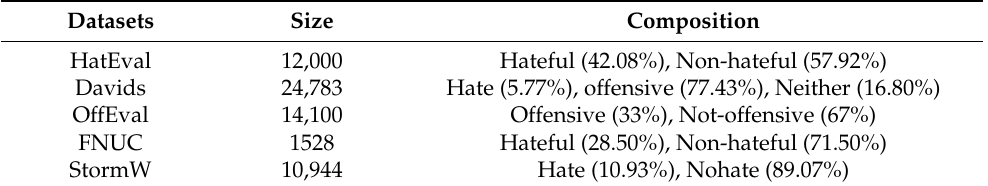
Table 1. Characterization of the datasets. The table below details the distribution of the number and composition of abuse language across the various